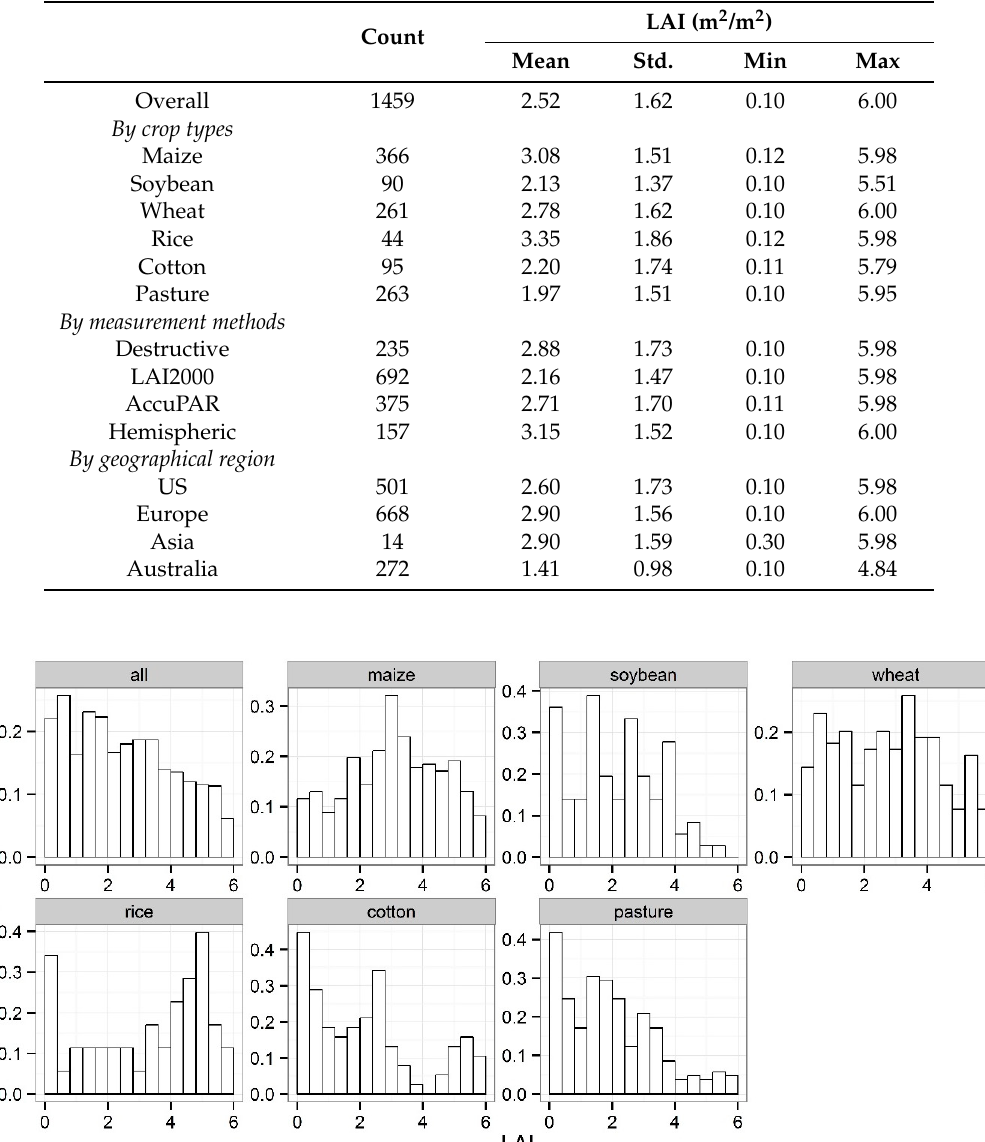
Table 2. Statistics of leaf area index (LAI) dataset by crop type, measurement method, and region.